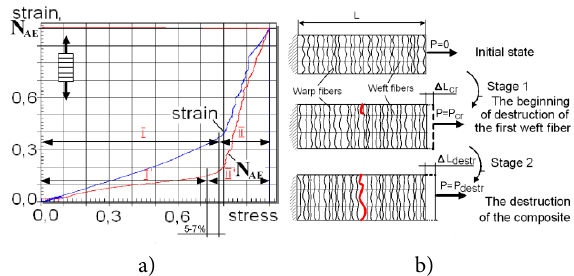
Fig. 4. Curve of the total AE change and deformation due to the stress-strain and the assumed mechanism of destruction of the composite with a transverse warp fiber position relative to the tensile strength (B)